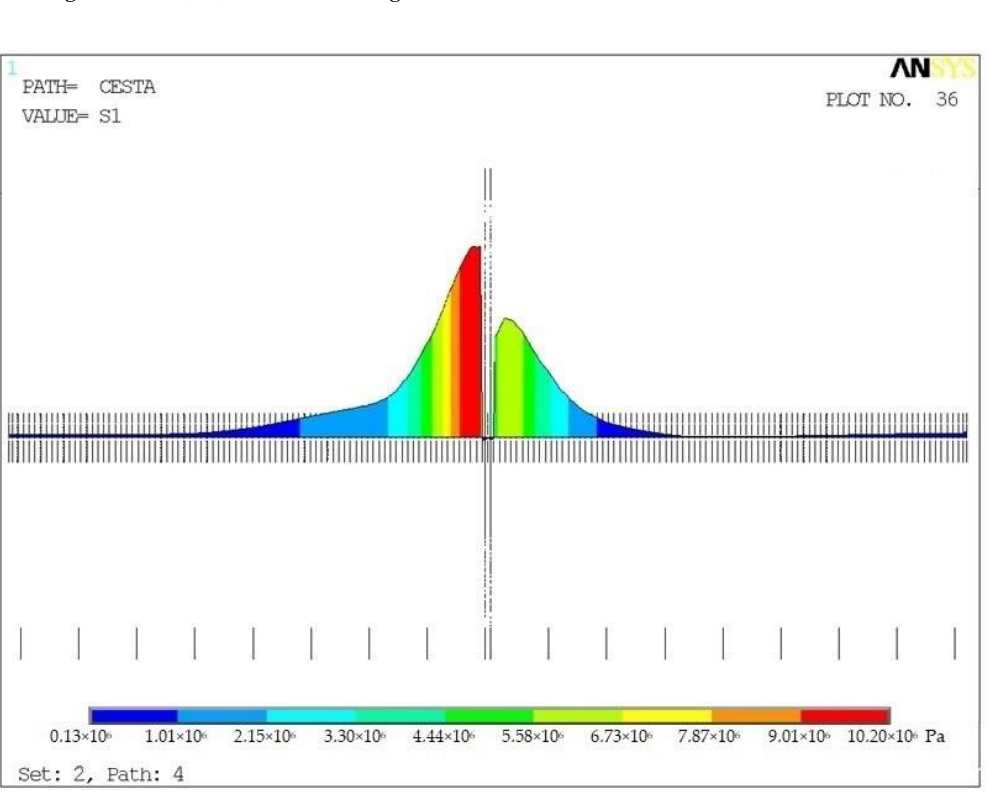
Figure 11. Main tensile stress in concrete for variant V12, Path